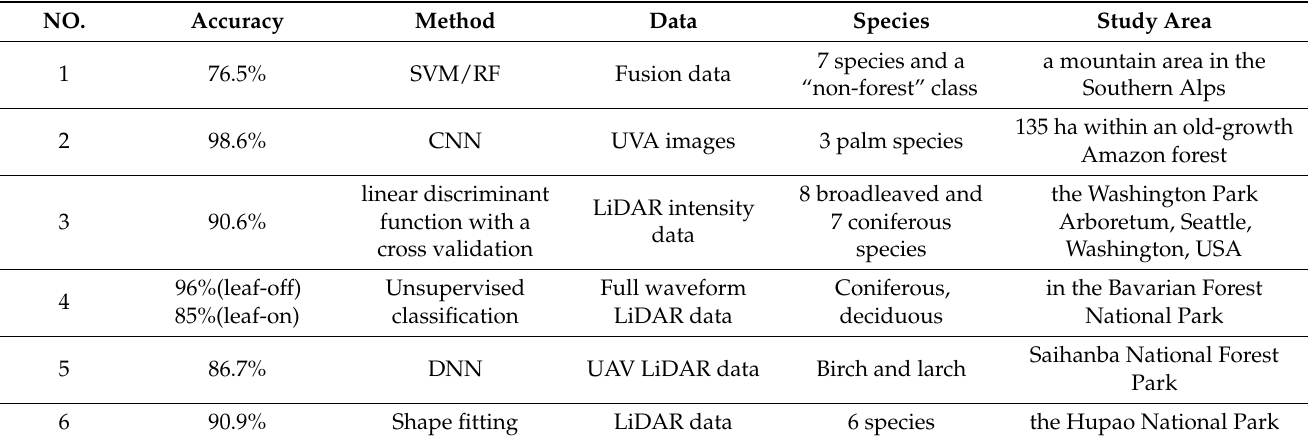
Table 7. The accuracy of different tree species classification